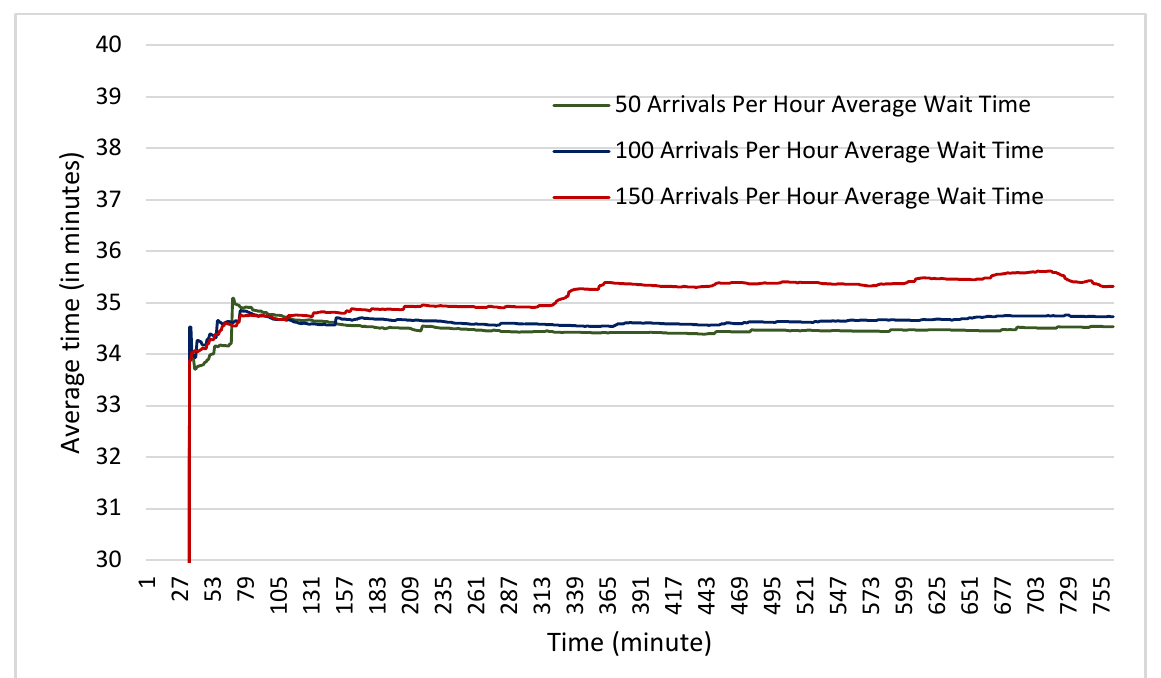
Figure 5. Average time spent waiting by clients at each of the arrival rates for a facility with no physical distancing measures measured in minutes.